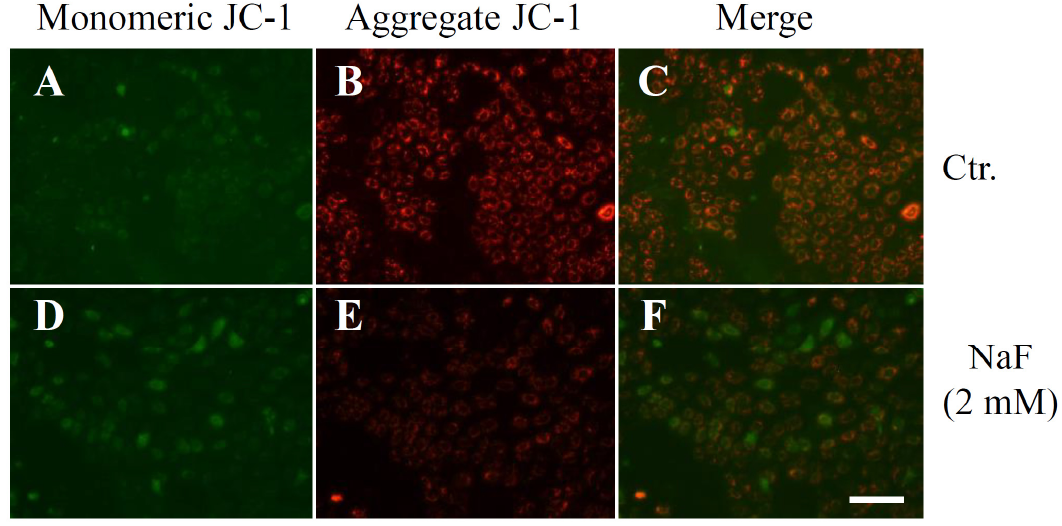
Figure 3. Effects of NaF on mitochondrial membrane potential (MMP) in ROE2 cells. Cells were cultured with or without 2 mM of NaF for 6 h. MMP was measured by JC-1, an indicator of mitochondrial function. ( A , D ) monomeric JC-1 green fluorescence; ( B , E ) aggregate JC-1 red fluorescence; and ( C , F ) merge images. ( A – C ) control cells (Ctr.); and ( D – F ) NaF-treated cells. Ctr., control. Scale Bar, 200 μ